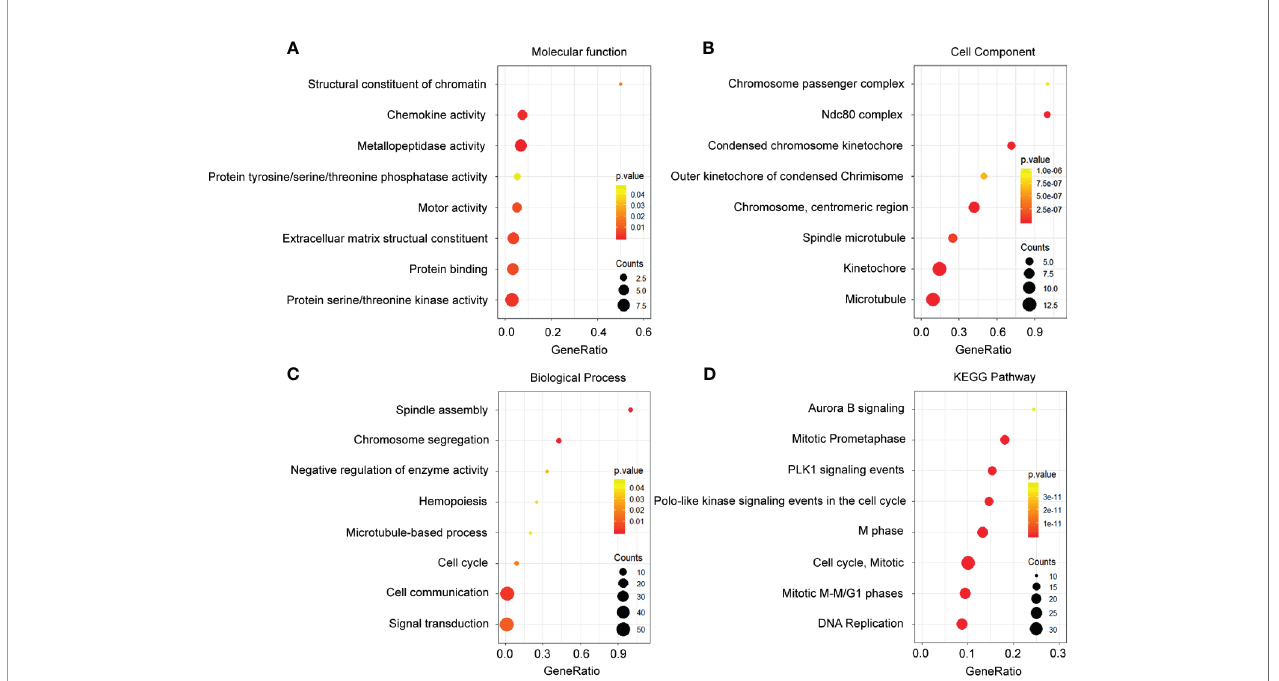
FIGURE 3 | Functional enrichment analysis of the upregulated genes. (A) Enrichment of molecular function. (B) Enrichment of cellular component. (C) Enrichment of biological process. (D) Enrichment of Kyoto Encyclopedia of Genes and Genomes.